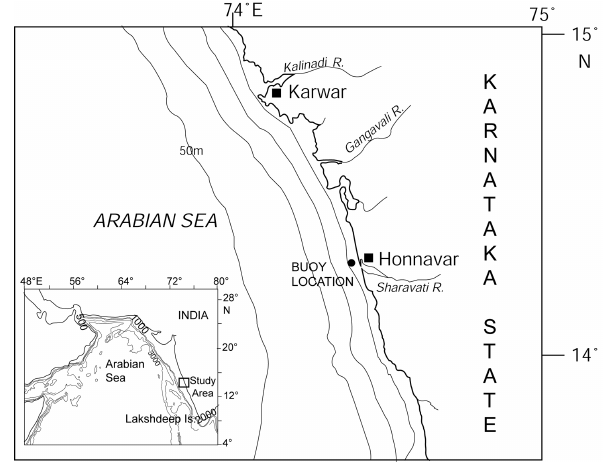
Figure 1. Map showing the study location. Figure 2. Time series plot of maximum spectral energy density in a calendar year during